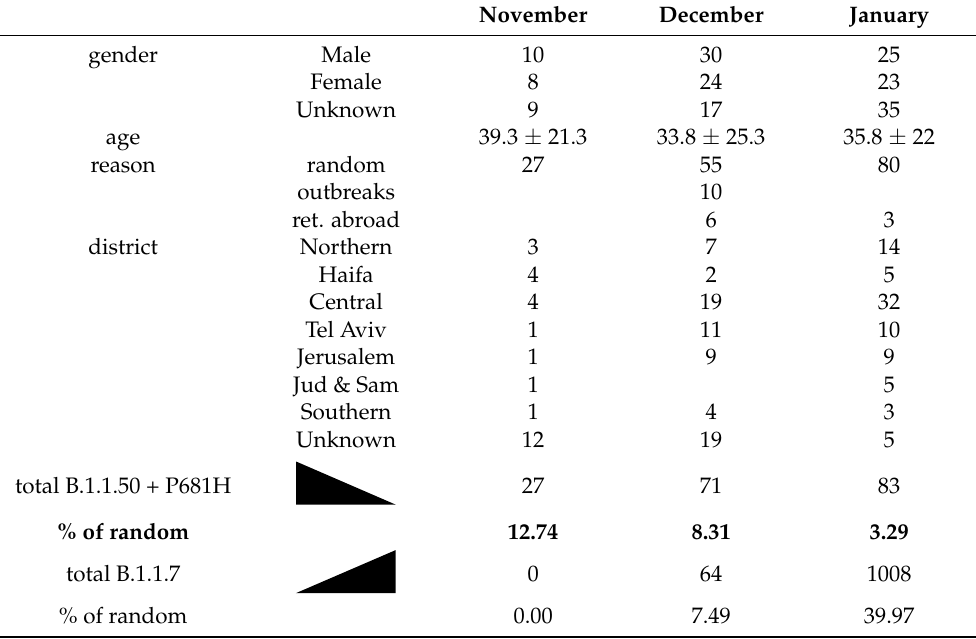
0% in November to ~40% in January. Table 1. Epidemiology of the B.1.1.50 + P681H variant. Frequency and patient-related information of the B.1.1.50 + P681H variant. Ret. abroad is return from abroad; Jud & Sam is Judea and Samaria.